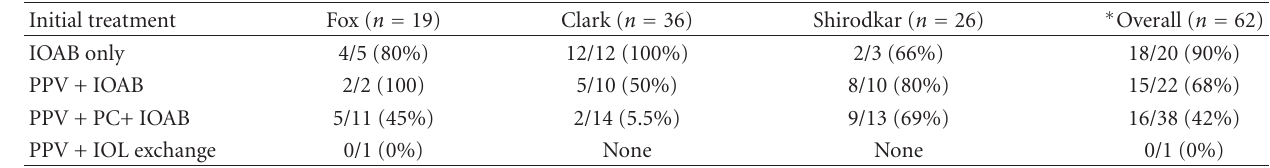
Table 5: Recurrence rate of chronic post operative endophthalmitis with di ff erent initial treatment modalities [5, 18, 28]. Initial treatment